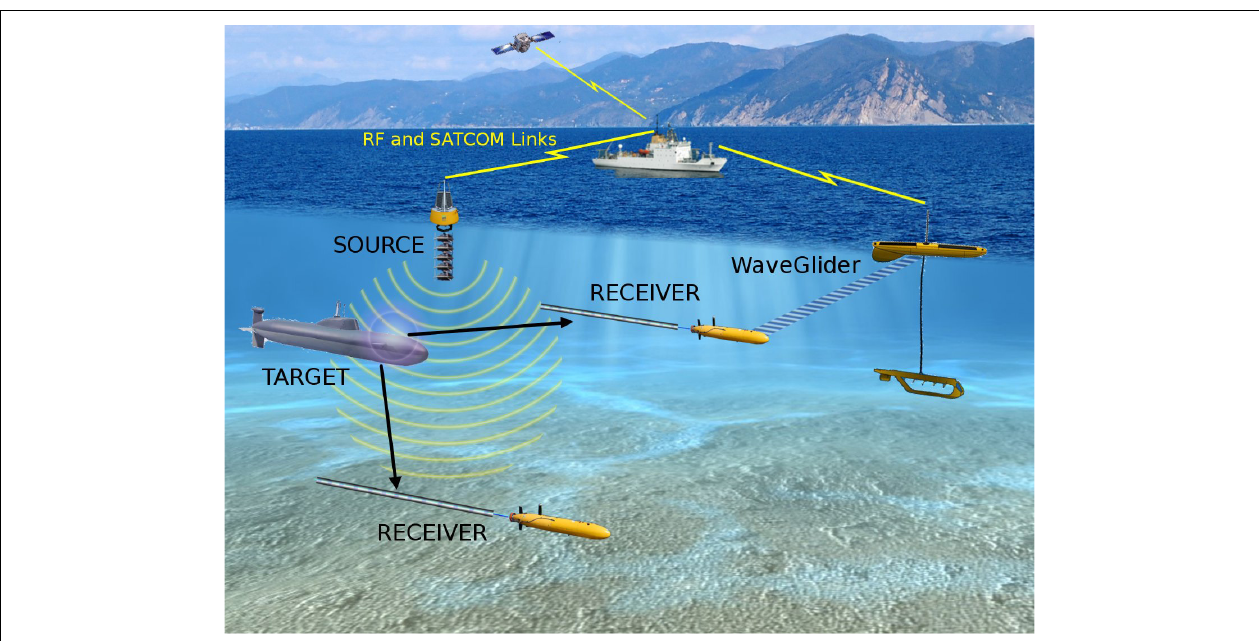
FIGURE 5 | A conceptual description of a cooperative network of